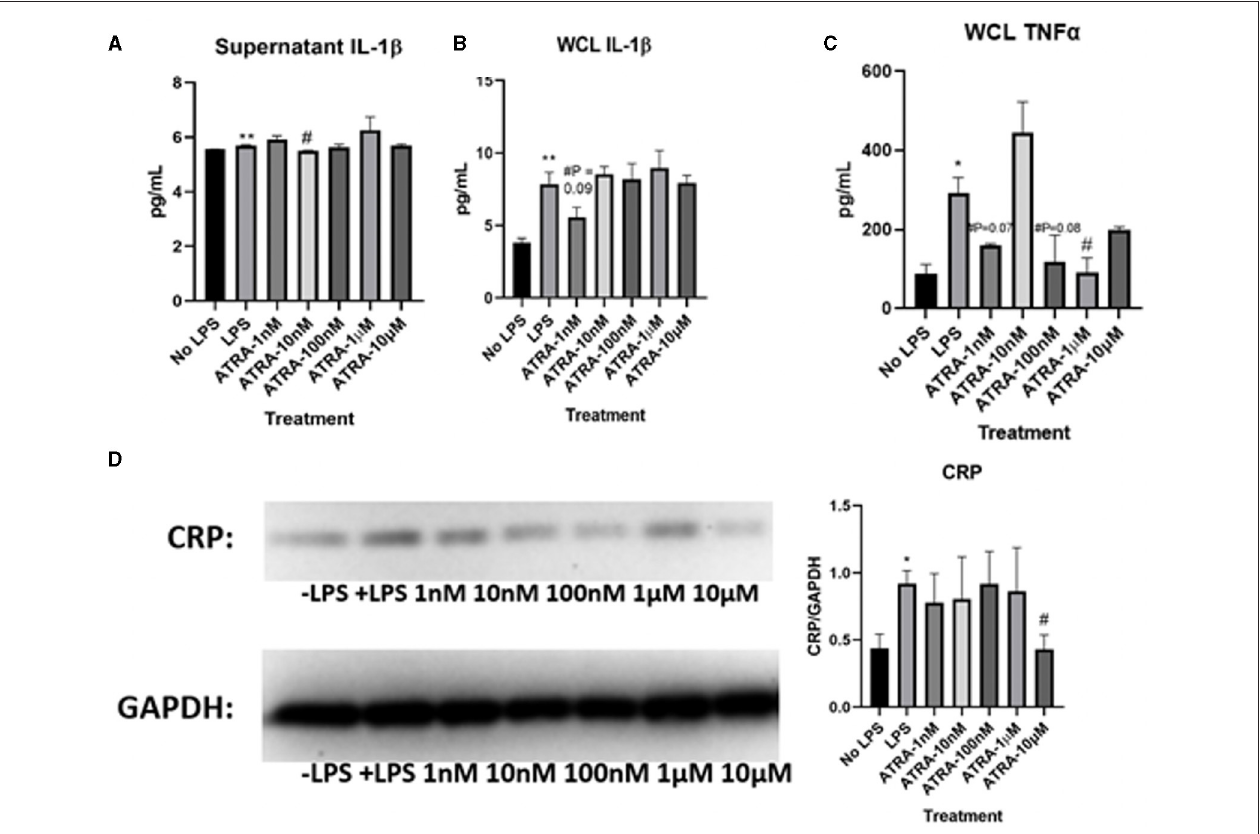
FIGURE 4 | ATRA minimally affects LPS-induced inflammatory markers. (A–C) Graphical representations of fold changes in pro-inflammatory cytokines detected via ELISA: (A) Cytokine levels of IL-1 β in HT-29 cell culture supernatants; (B) IL-1 β levels in HT-29 whole cell lysates (WCL); (C) TNF- α levels in WCL. (D) Western blot of CRP expression in WCL. Five treatment doses of ATRA (1, 10, 100nM, 1, 10 µ M). Four replicates were used for statistical analysis in ELISA and western blot. Values are means ± SEMs. *significance at p < 0.05 for comparison with the ‘No LPS’ group, **significance at p < 0.01 for comparison with the “No LPS” group. # significance at p < 0.05 for comparison with the “LPS”